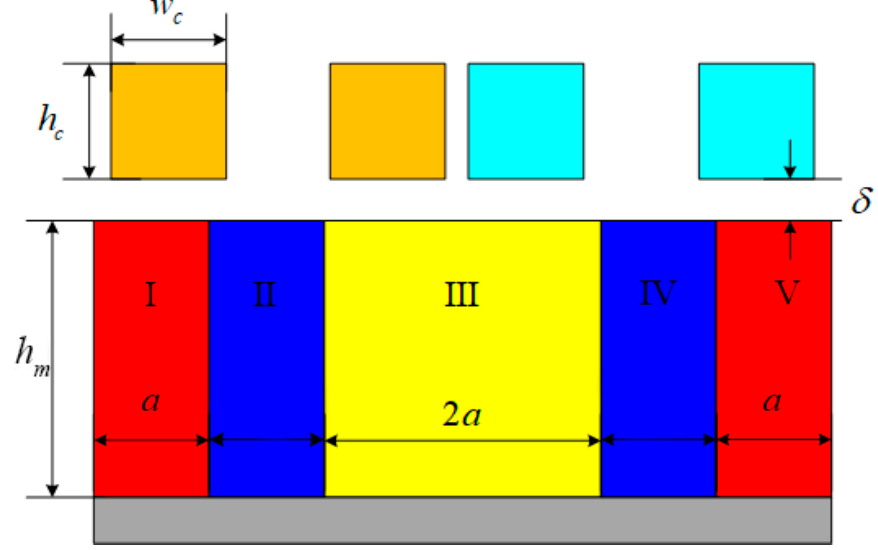
Figure 4. The main dimensional parameters in the motor’s cross-section.